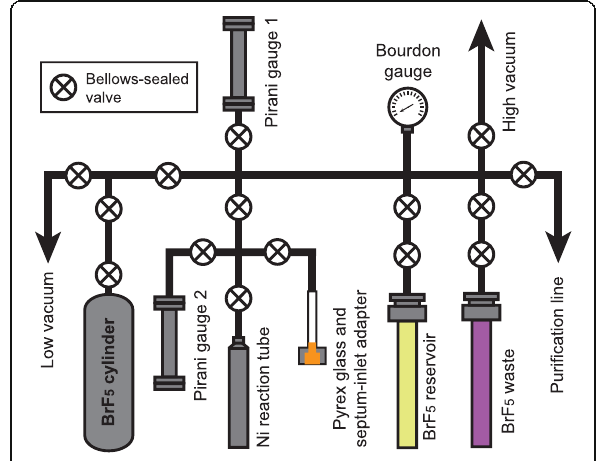
Fig. 1 Schematic diagram of BrF 5 introduction and water fluorination line modified from Kim et al. (2019). Two microliters of water was introduced into the vacuum line through a septum-inlet using a micro-syringe and then transferred in a Ni reaction tube with BrF 5 at liquid nitrogen temperature. The reaction was run at 200 °C for 1